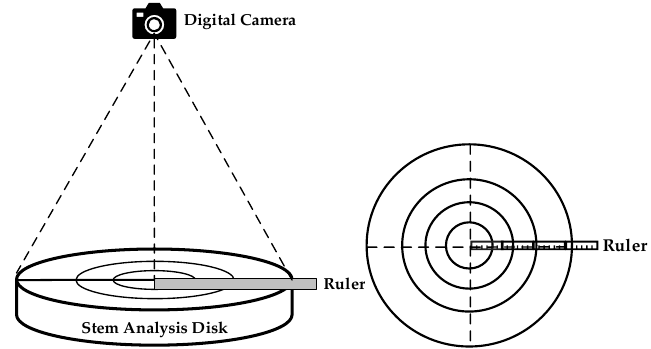
Figure 2. Shooting schematic of stem analysis disk digital image.